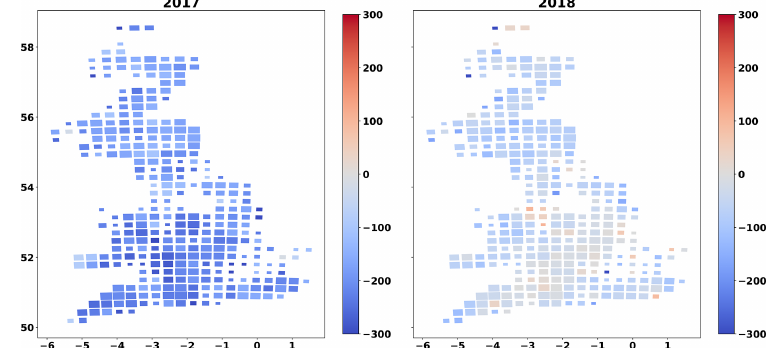
Figure A6. Cartograms of MDF-predicted NBE for 2017 and 2018. The mean across all fields in each cell is presented. The size of cells is adjusted according to the number of simulated fields within it. Unit: gCm − 2 yr − 1 .